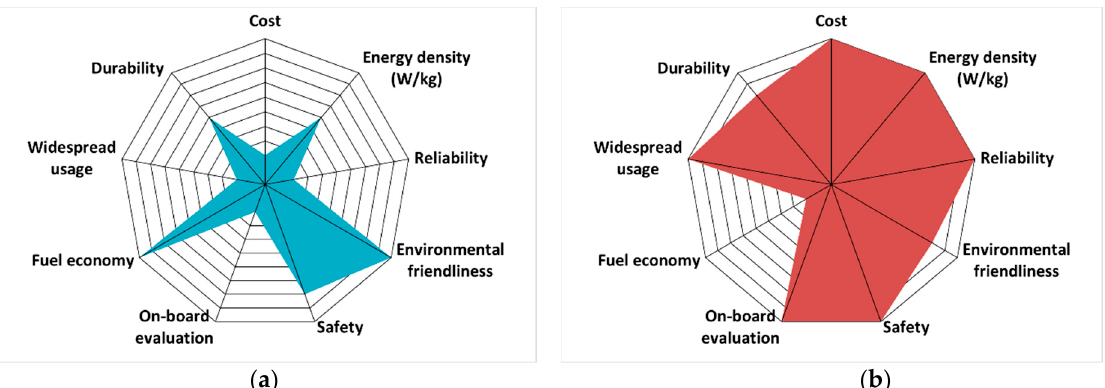
Figure 14. Current development status of automobile air conditioning systems. ( a ) Adsorption system and ( b ) mechanical vapour compression system. Note. Cost and reliability components for adsorption systems are assumed to be low since no data is available.